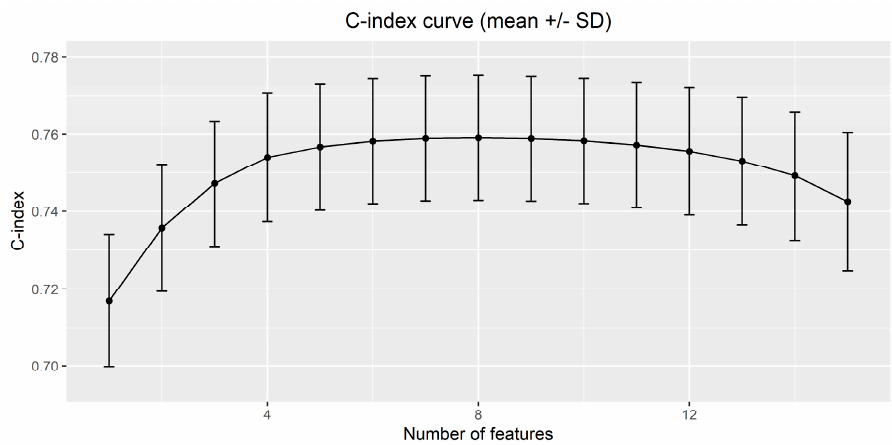
Figure 6. Mean +/ − SD of the C-index on the out-of-bag sample obtained by the proposed variable ranking algorithm.